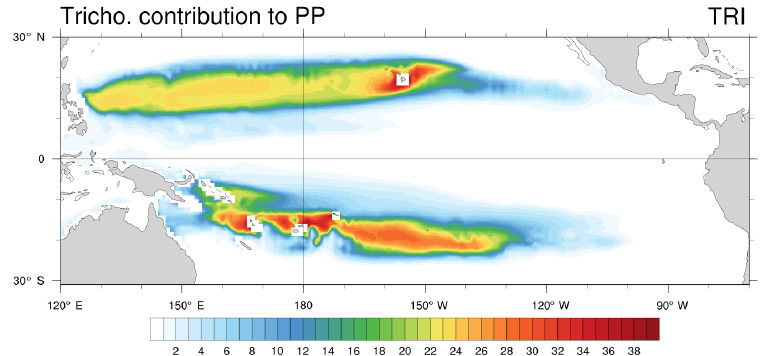
Figure 5. Relative contribution (in percentage) of Trichodesmium to total primary production.